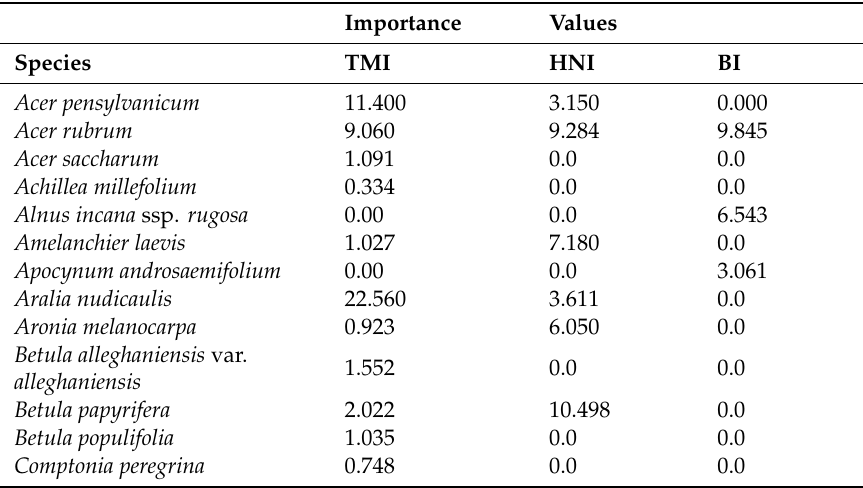
Table 1. Understory Importance Values for Three Mile Island (TMI), Hawk’s Nest Island (HNI), and Blueberry Island (BI) in 2011. Importance values (IV) are calculated as the sum of relative percent cover and relative